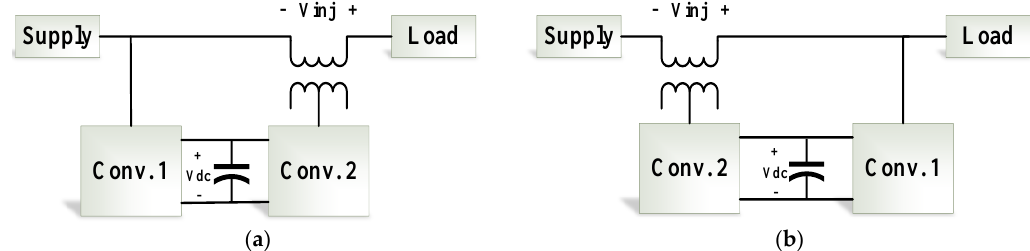
Figure 5. DVR topologies with no energy storage in ( a ) supply-side, ( b ) load-side. Based on data from [7,54].